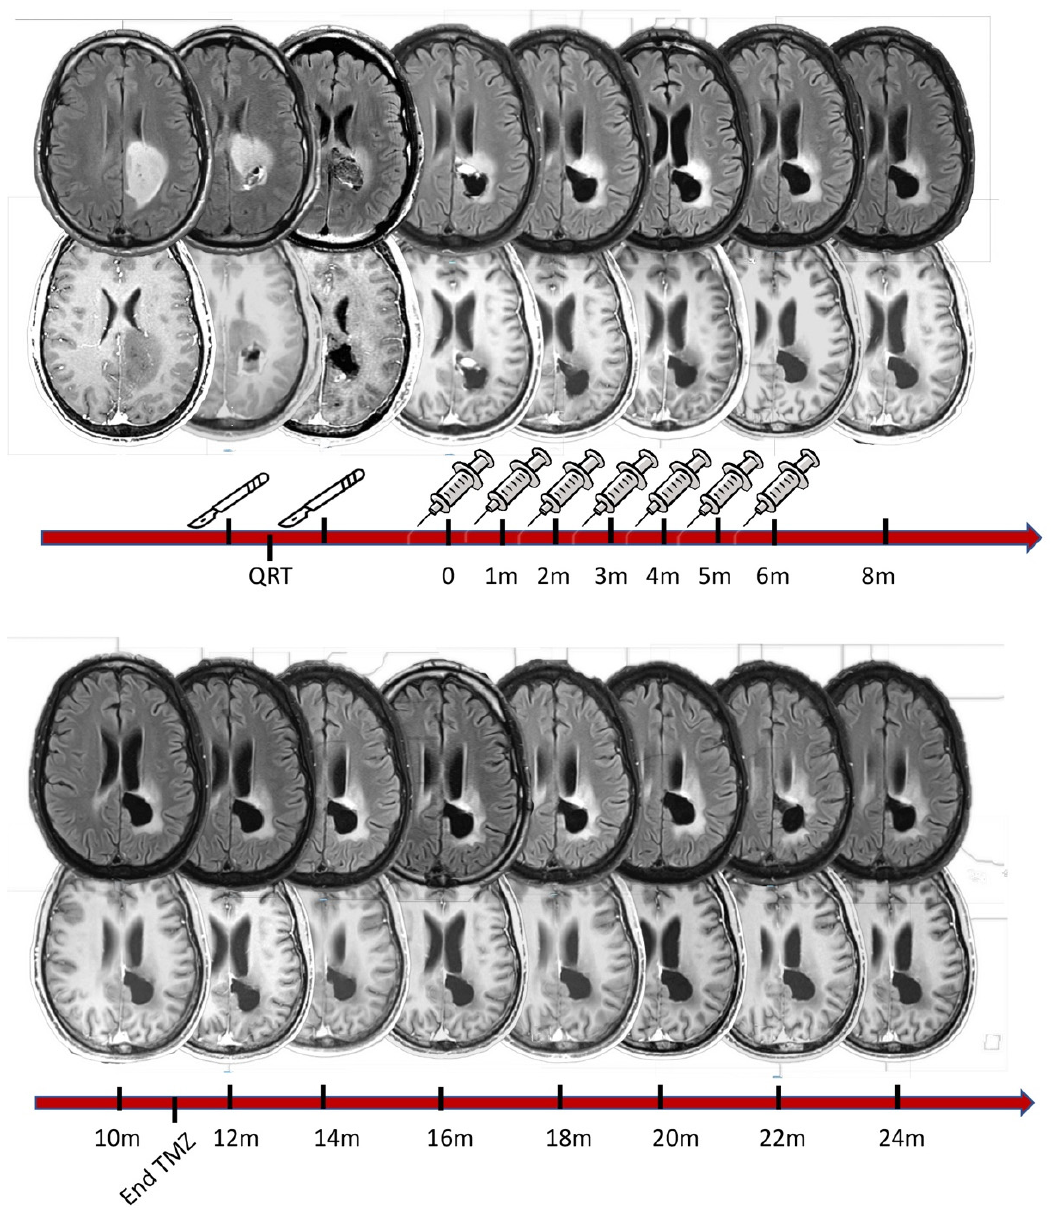
Figure 1. Illustrative case of a 28-year-old male patient whose initial symptoms were motor weakness and partial motor seizures in the right leg. The first column of MRI scans ( top panel , left) represents the patient’s first MRI scan ( top : flair sequence; bottom : T1 with gadolinium). The images seen in the second column were acquired following a first surgical resection in which roughly 50% of the tumor mass was removed. The first pathology exam revealed glioblastoma, IDH-1 wild type (according to the WHO classification from 2021). The patient then began chemotherapy with temozolomide, concomitant with 60 Gy radiotherapy fractioned into 30 sessions. Three months after the first surgery, the tumor had progressed, which led to a second surgical resection (indicated by scalpels in the figure). This resection was limited anteriorly when electrophysiological monitoring detected deteriorating motor evoked potentials on the right side of the body. The post-operative MRI showed remaining tumor tissue. At that time, the patient was already enrolled in the trial and received the first vaccination dose 3 months after the second surgery. In total, he received 7 doses at monthly intervals, as illustrated above, concomitant with 12 maintenance cycles of temozolomide, which finished 11 months